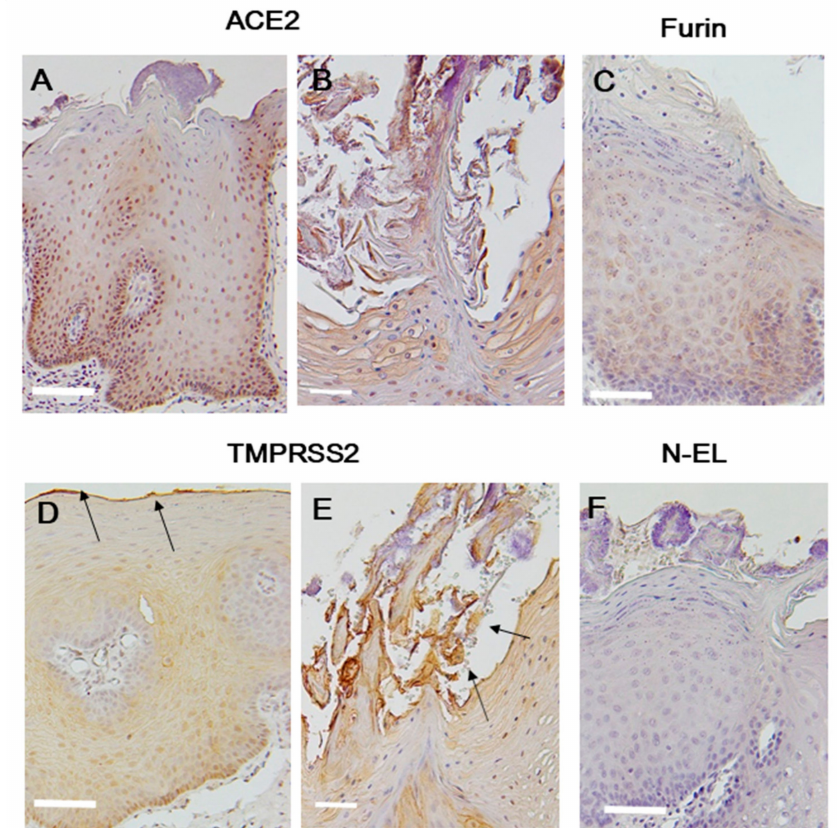
Figure 1. ACE2: Tongue epithelium staining largely in the spinous and basal cell layers ( A ). The upper layer of the tongue epithelium shows bacteria and strong positive staining within cells ( B ). Furin: Tongue epithelium showing consistent staining in the spinous and basal cell layers ( C ). TMPRSS2: Tongue epithelium showing positive staining ( D ). The upper layer of the tongue epithelium shows bacteria and strong positive staining within cells ( E ). N-EL: No immunostaining signals ( F ). The arrows indicate a strong immunochemical positive signal. Scale bar = 50 µ m. ACE2, angiotensin-converting enzyme 2; TMPRSS2, transmembrane protease serine 2; N-EL,